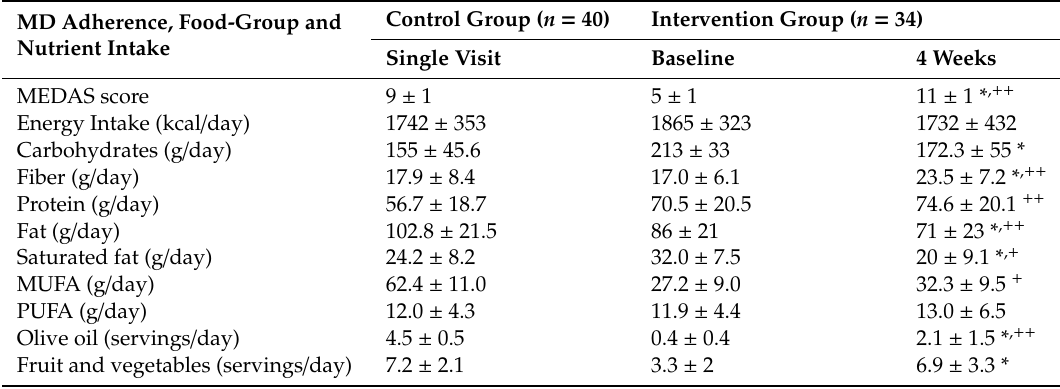
Table 3. Dietary intake and compliance with the Mediterranean diet between groups and time-points (mean ±